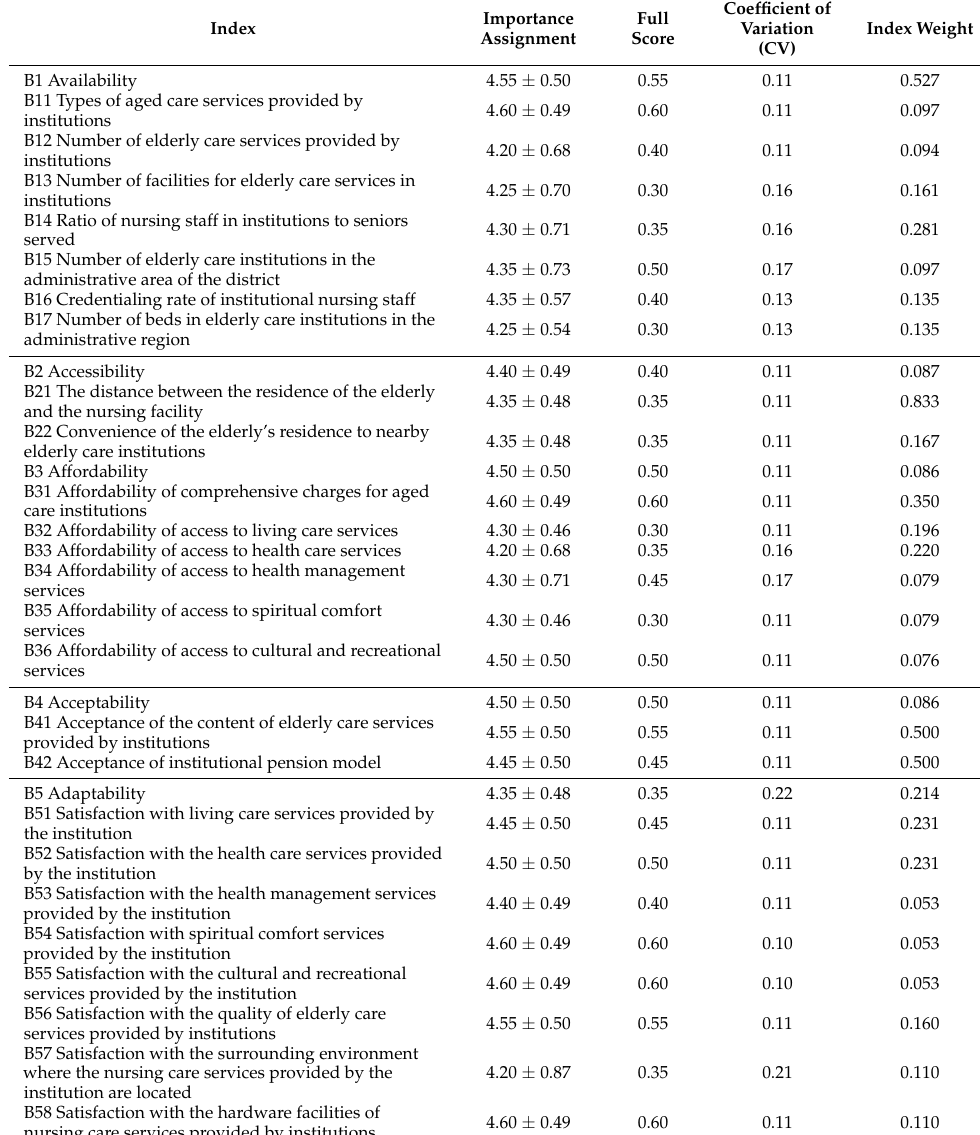
Table 7. Institutional aged care service